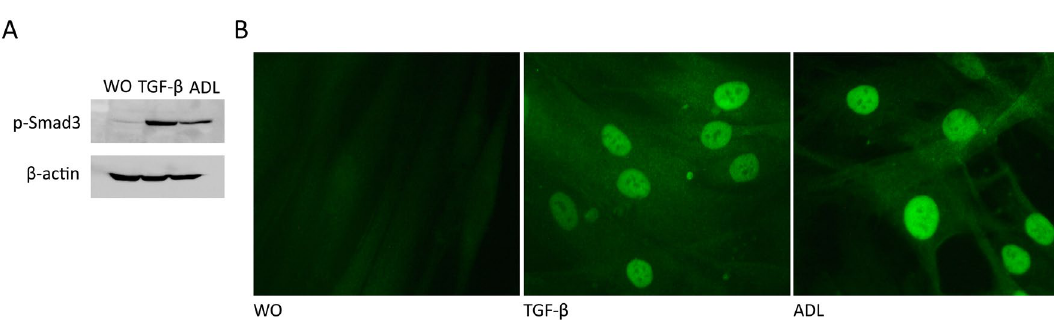
Figure 6. ADL induces phosphorylation of Smad3 and Smad2/3 signaling in primary gingival fibroblasts. Incubation of gingival fibroblasts with ADL caused ( A ) an increased phosphorylation of smad3 in Western blot. Representative immunofluorescence confirmed ( B ) the translocation of Smad2/3 into the nucleus upon stimulation with ADL. “WO” represents unstimulated control. Treatment with 10 ng/mL of TGF-β was used as a positive control. Scale bars indicate 50